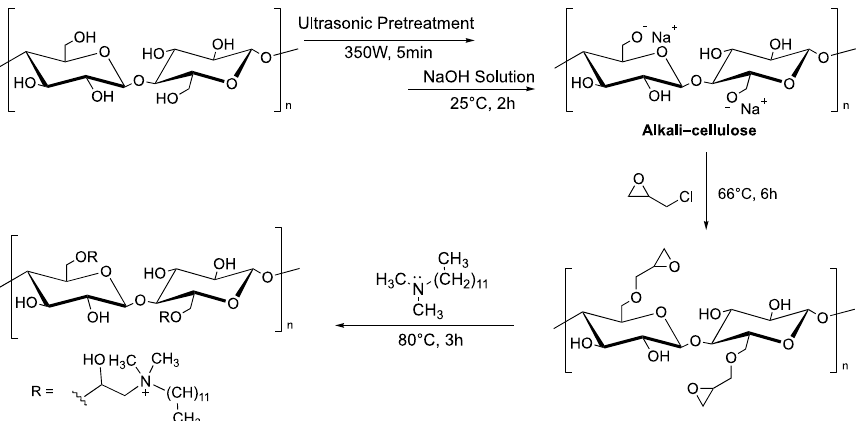
Figure 4. Two-step functionalization of MCC by reaction with glycidyl chloride, followed by ring opening with N , N -dimethyldodecylamine